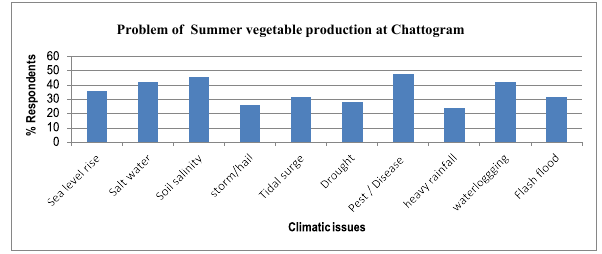
Figure 17: Farmers response on long term impacts of climate change affecting oil seed crops at Cox’s